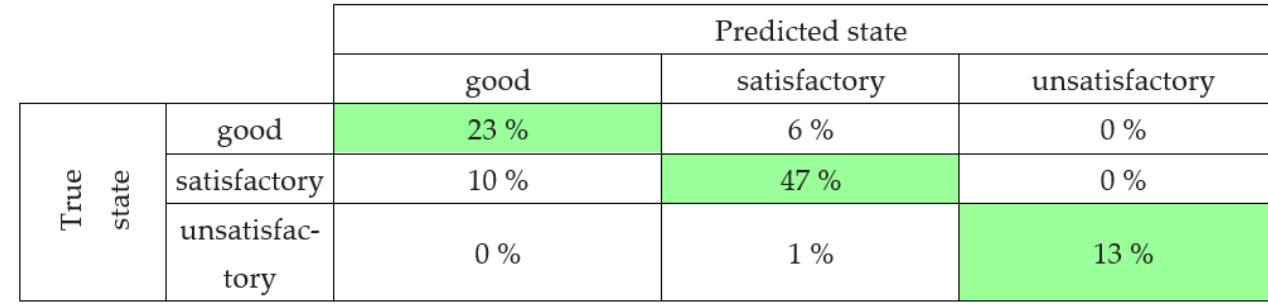
Figure 16. Feature importance for the XGBoost two-classifier model.